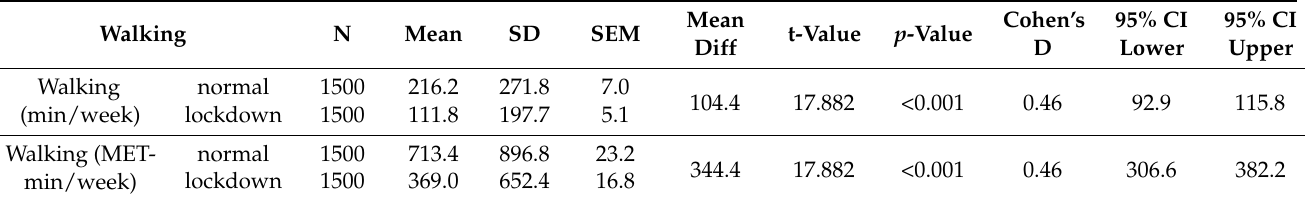
Table 4. Walking minutes per week and walking MET-minutes per week.